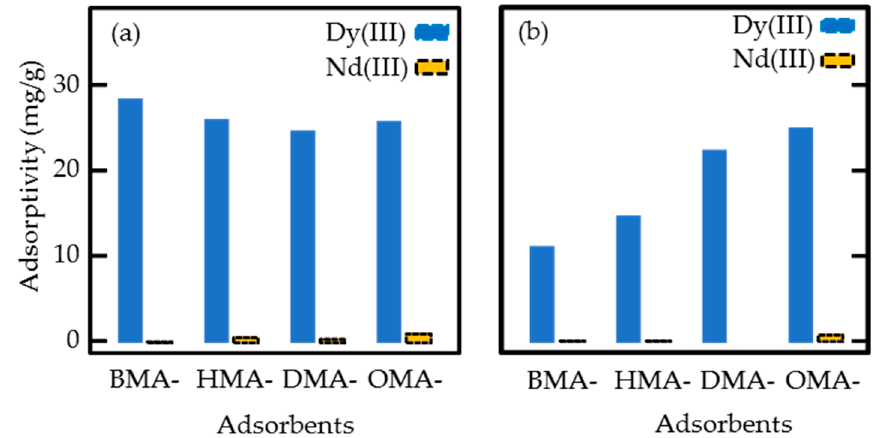
Figure 4. The Dy (III) and Nd (III) adsorptivity of the four nonwoven fabric adsorbents. ( a ) First adsorption test. ( b ) Second adsorption test using the refreshed adsorbents after elution and washing. Initial adsorption solution: 100 ppm Dy (III) and 100 ppm Nd (III) at a pH of 2.0 at 25 °C.